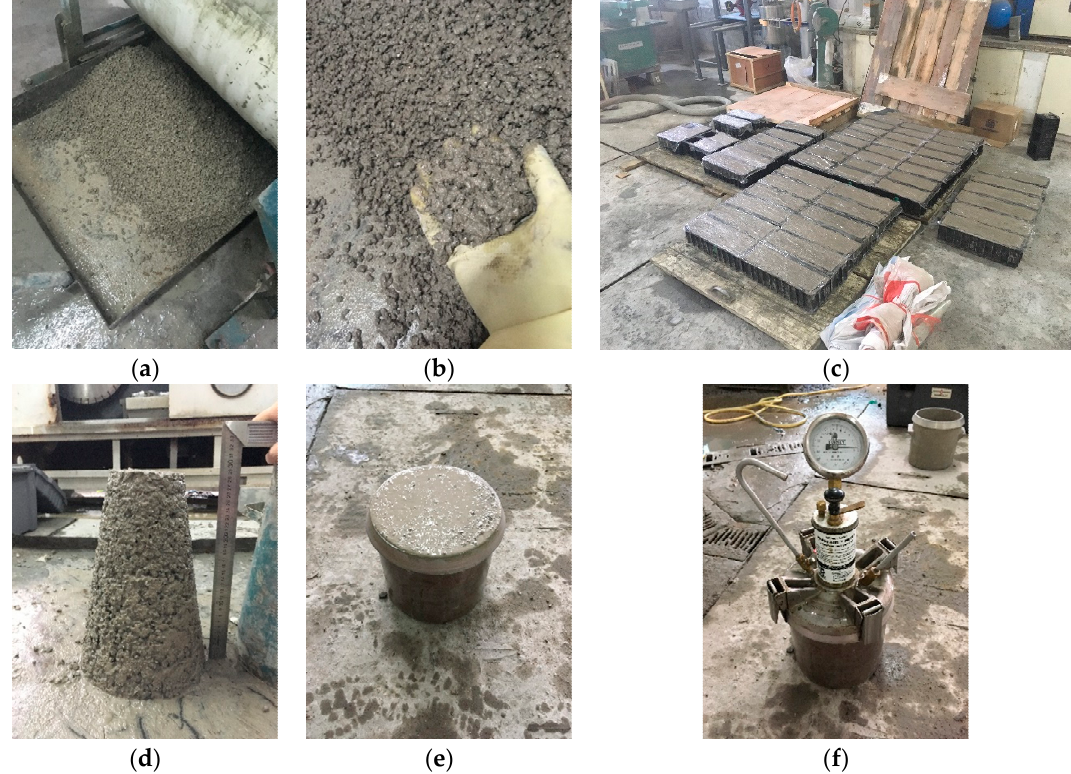
Figure 1. Manufacturing operation of alkali-activated slag (AAS) concrete: ( a ) mixture of AAS concrete; ( b ) state of the mixture; ( c ) casting of AAS concrete; ( d ) slump test of the ASS concrete; ( e ) AAS concrete after vibration; ( f ) air content test of AAS concrete.